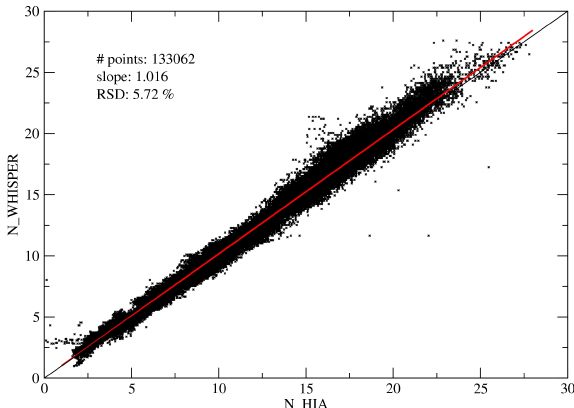
Fig. 6. Comparison between calibrated HIA and WHISPER data on Cluster 1. All magnetosheath intervals sampled by the HIA HS side between 15 December 2006 and 15 February 2007 were selected for comparison using selection criteria similar to those presented in Sect. 4. The regression line crossing the origin is shown in red.